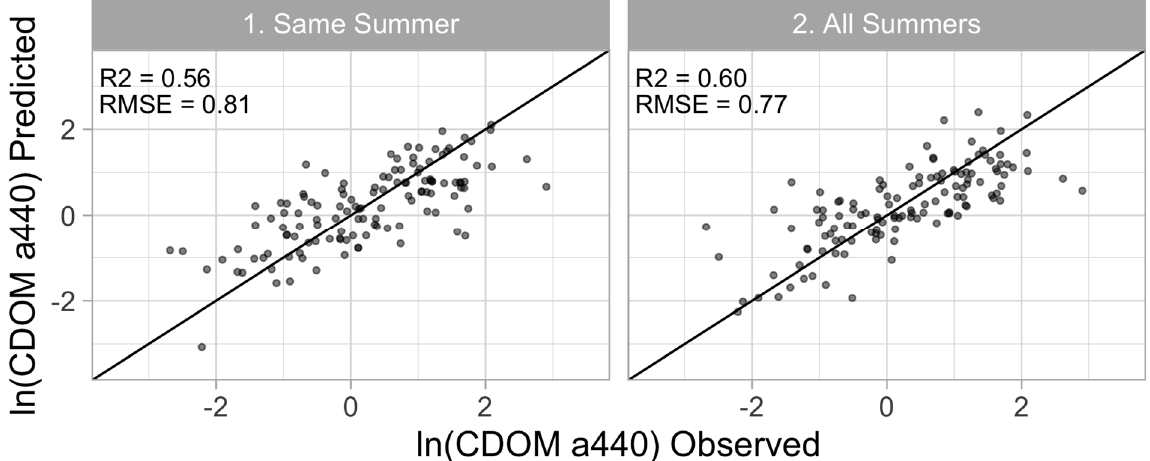
Figure 7. Estimating CDOM( a 440 ) in lakes with sampled CDOM( a 440 ) but that were not in the calibration or validation sets ( n = 128). These lakes were left out of model construction and the initial validation because there was no match within 30 days (i.e., no repeat lakes from the calibration or validation sets). Here, we look at only two time windows: ( 1 ) clear images from the same summer as field sampling; ( 2 ) all clear summer images from all years of the Landsat 8 record (2013–2019). Diagonal lines represent the 1:1 line.